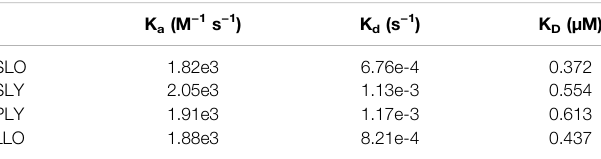
TABLE 2 | Interacting af fi nities of luteolin to SLO, SLY, PLY, LLO measured by